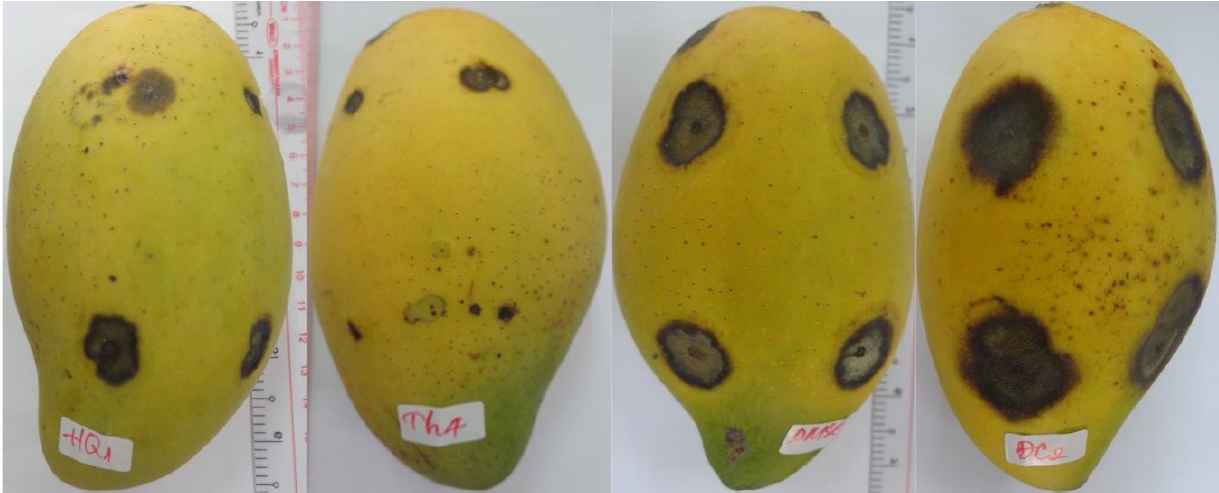
Figure 5. Anthracnose lesion on mango fruits of Cat Hoa Loc variety under effect of different treatments at 7 D.A.I. From left to right: basil EOs, fungicide, DMSO, and distilled water treatment.